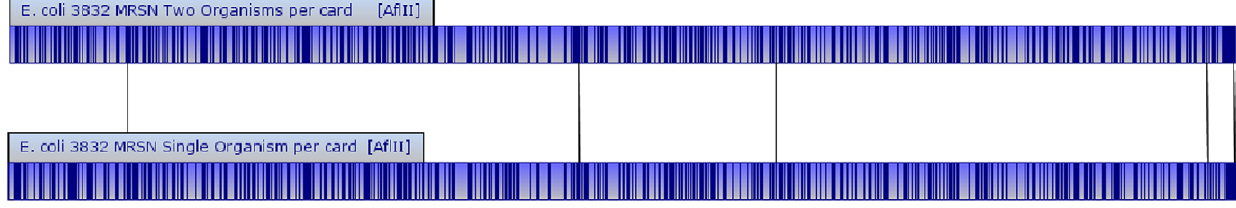
Figure 2. E.coli Genomes. Complete circularized E. coli genome maps created as a result of a mixed DNA mapcard run aligned to an identical map from individual run.